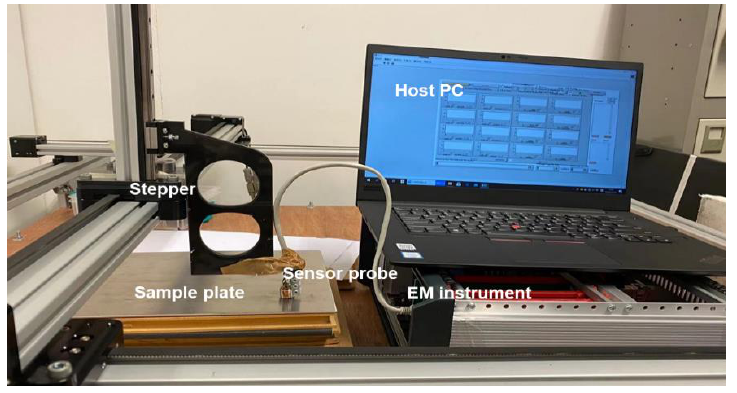
Figure 7. Experimental setup.